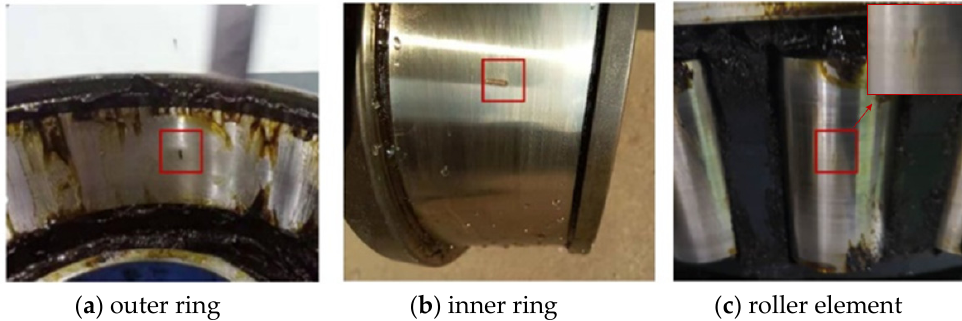
Figure 10. The damage location. ( a ) outer ring; ( b ) inner ring; ( c ) roller